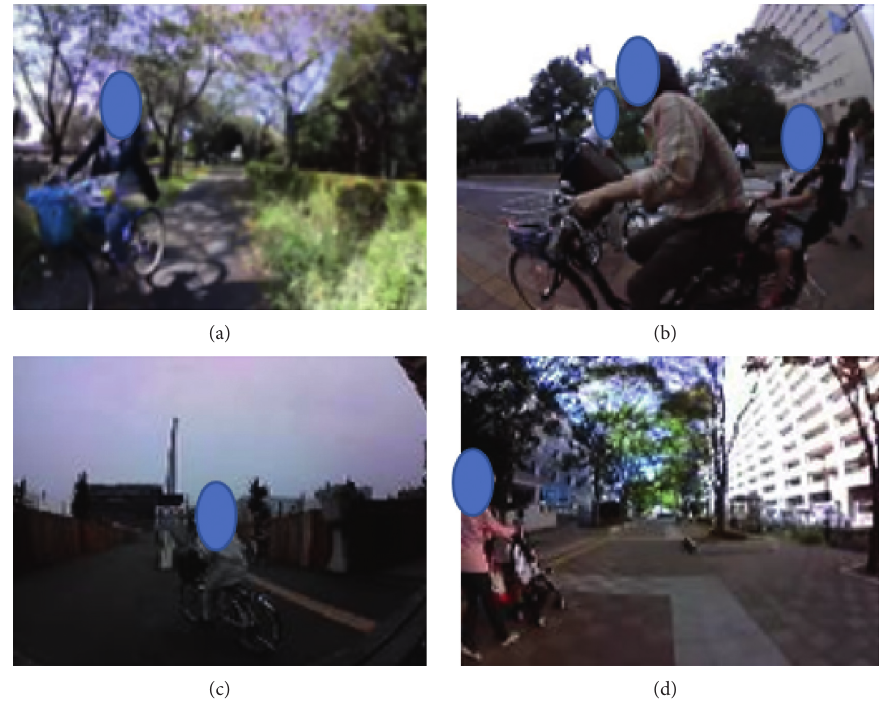
Figure 8: Scenes of the categorized events of scenario 1 (top left: section � D, objective � avoid, winglet � none; top right: section � E, event � cross, and winglet � none; bottom left: section � E, event � bicycle overtakes, winglet � none; bottom right: section � E, event � pass, and winglet � stop) (faces of persons unrelated to the study have been covered to protect their privacy). Table 8: t -test results for various differences in scenario 1 (avg: average; SD: standard deviation; accel: acceleration; ans: answer; Q: question).